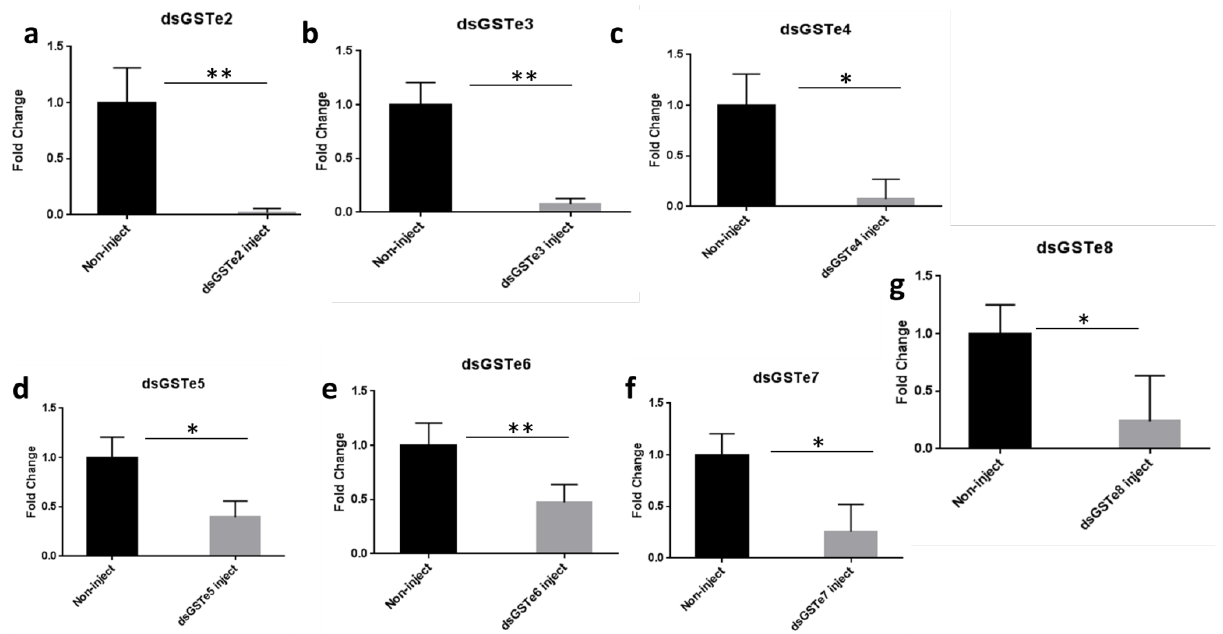
Figure 3. Confirmation of GSTe knockdown effect by quantitative RT-PCR between non-exposed double-strand injected and non-injected mosquitoes of the same age ( a ) ds GSTe 2, ( b ) ds GSTe 3, ( c ) ds GSTe 4, ( d ) ds GSTe 5, ( e ) ds GSTe 6, ( f ) ds GSTe 7, ( g ) ds GSTe 8,. There is low expression of all GSTe injected mosquitoes compared to the non-injected mosquitoes. dsRNA injection significantly reduces the expression of the GST epsilon genes. * = p < 0.05, and ** = p < 0.01.